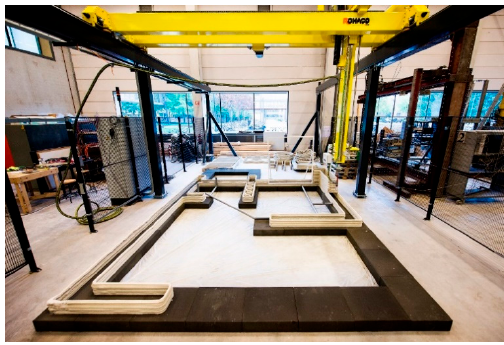
Figure 1. 3D concrete printing facility at the TU/e.